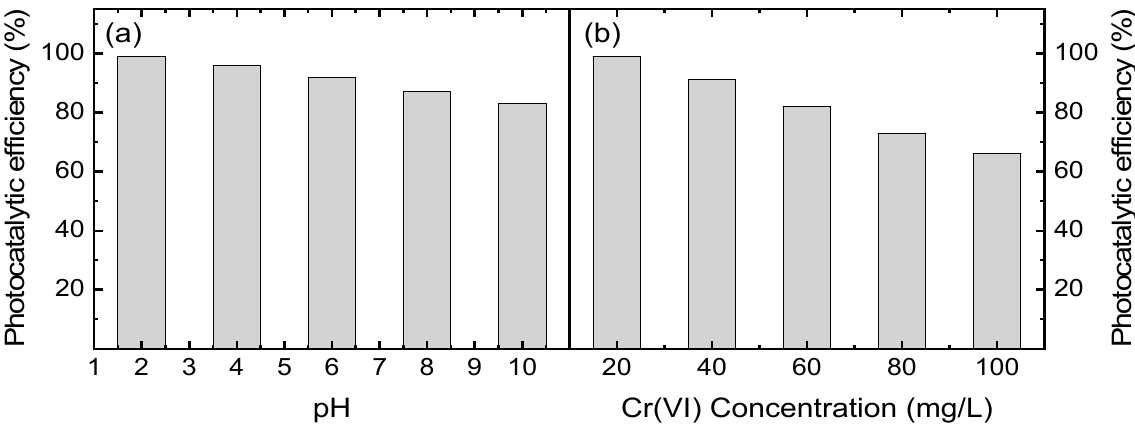
Figure 4. Photocatalytic efficiency of Cr(VI) using PES nanofiber, PES/MWCNTs-Fe 3 O 4 CNM, and MWCNTs-Fe 3 O 4 @PES CNM.